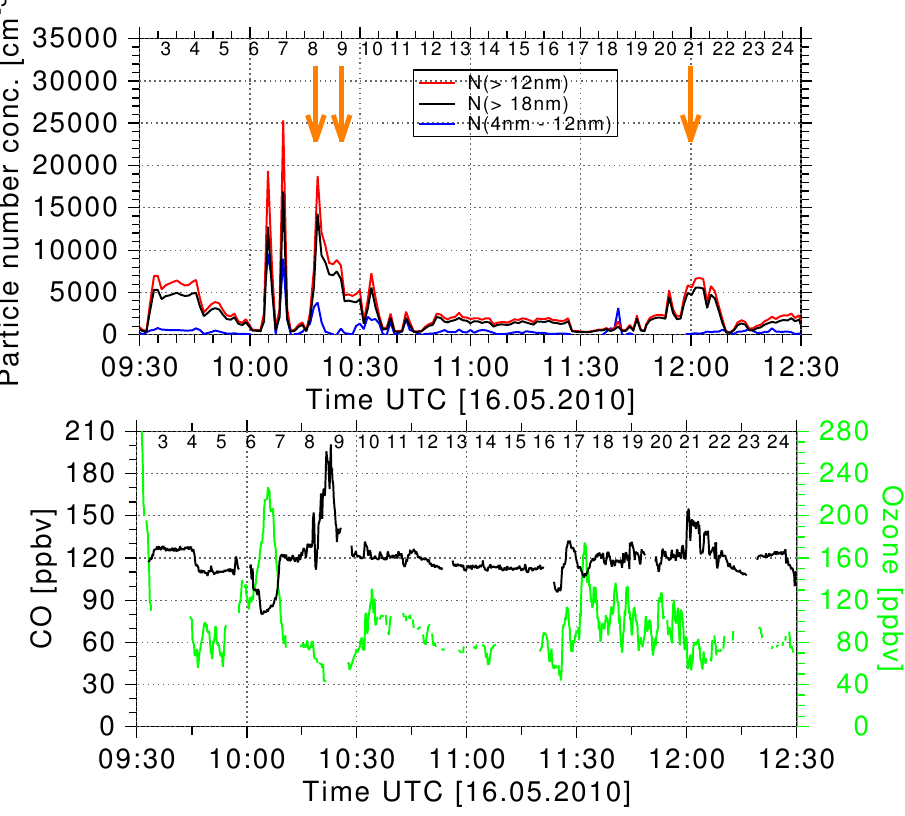
Fig. 5. Measurements from the CARIBIC volcano flight on 16 May 2010 at the time of volcanic cloud interception (see arrows). The numbers close to the upper margin mark the whole air samples. Upper panel: particle number concentrations from the CPCs in different size ranges for nucleation mode particles (4nm–12nm diameter, blue), particles between 12nm and 2µm diameter (red) and particles between 18nm and 2µm diameter (black). Lower panel: carbon monoxide (CO, in black) and ozone (O 3 , in green). Gaps in the time series are caused by calibrations (CO) or missing data (O 3 ).